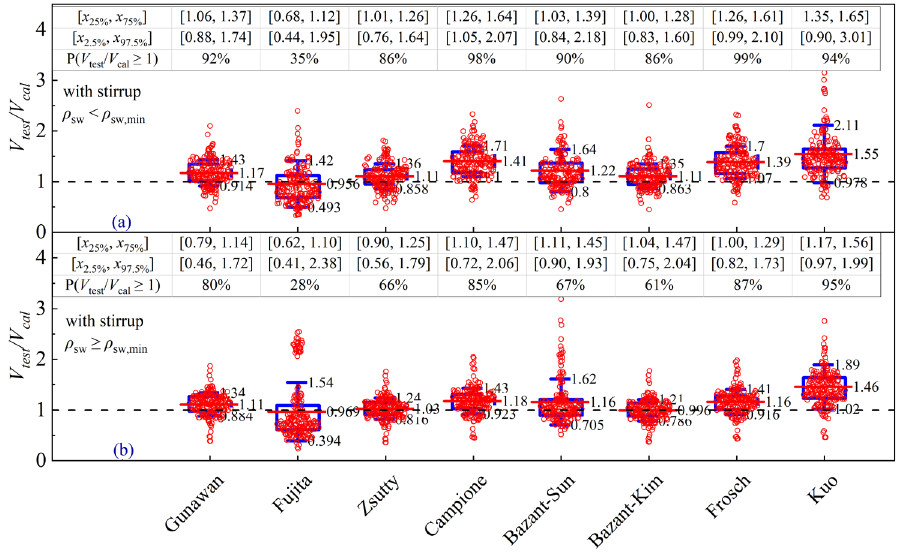
Figure 17. Researchers: prediction results versus ( a ) ρ sw < ρ sw,min and ( b ) ρ sw ≥ ρ sw,min .